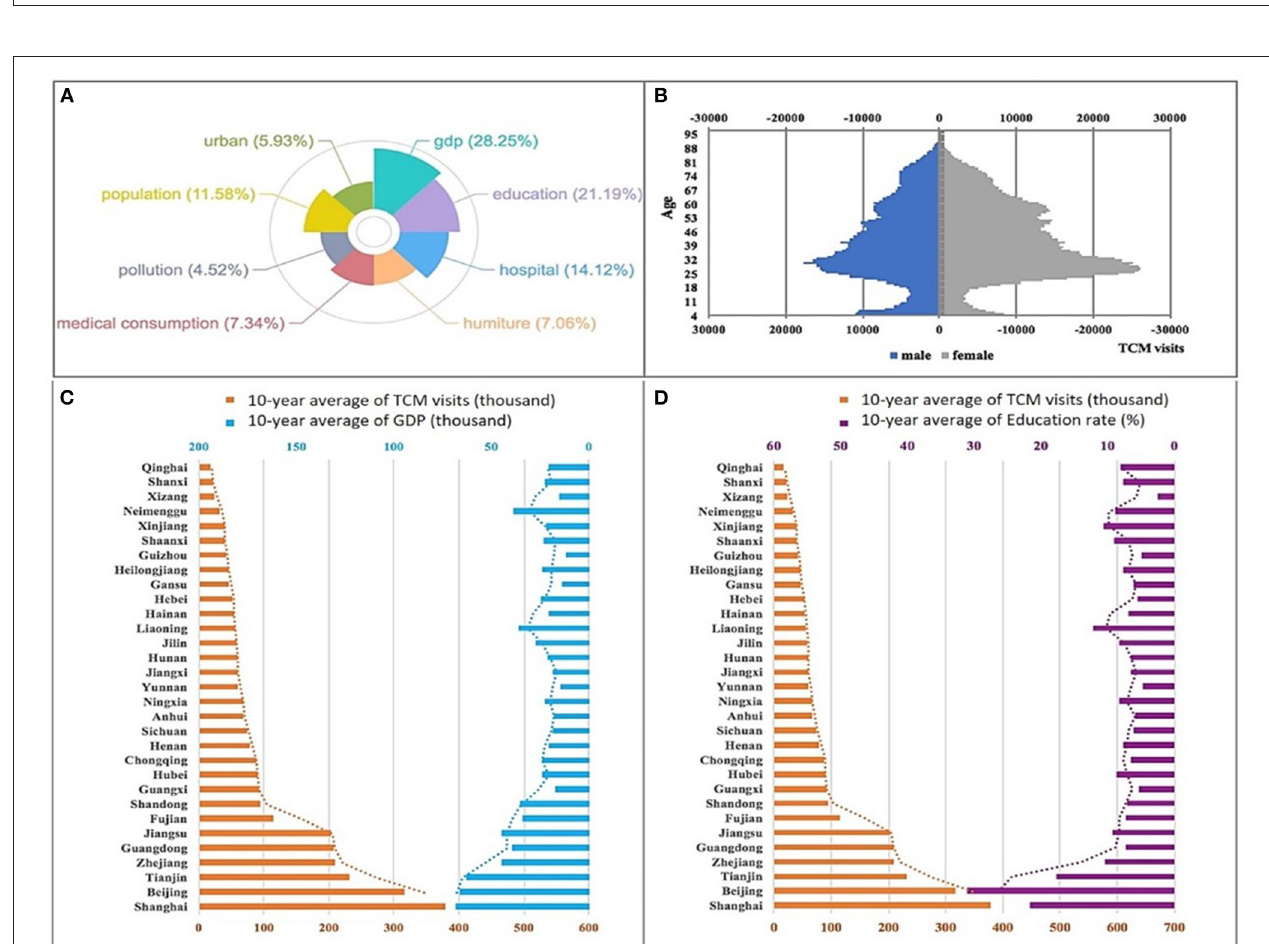
FIGURE 2 | The characteristics of populations utilizing TCM treatments. (A) The factor analysis results of Lasso Regression on the NBSPR data. (B) The age distribution of Xiyuan Hospital’s visit population. (C) The relationship analysis between GDP and TCM visits. (D) The relationship analysis between education rates and TCM